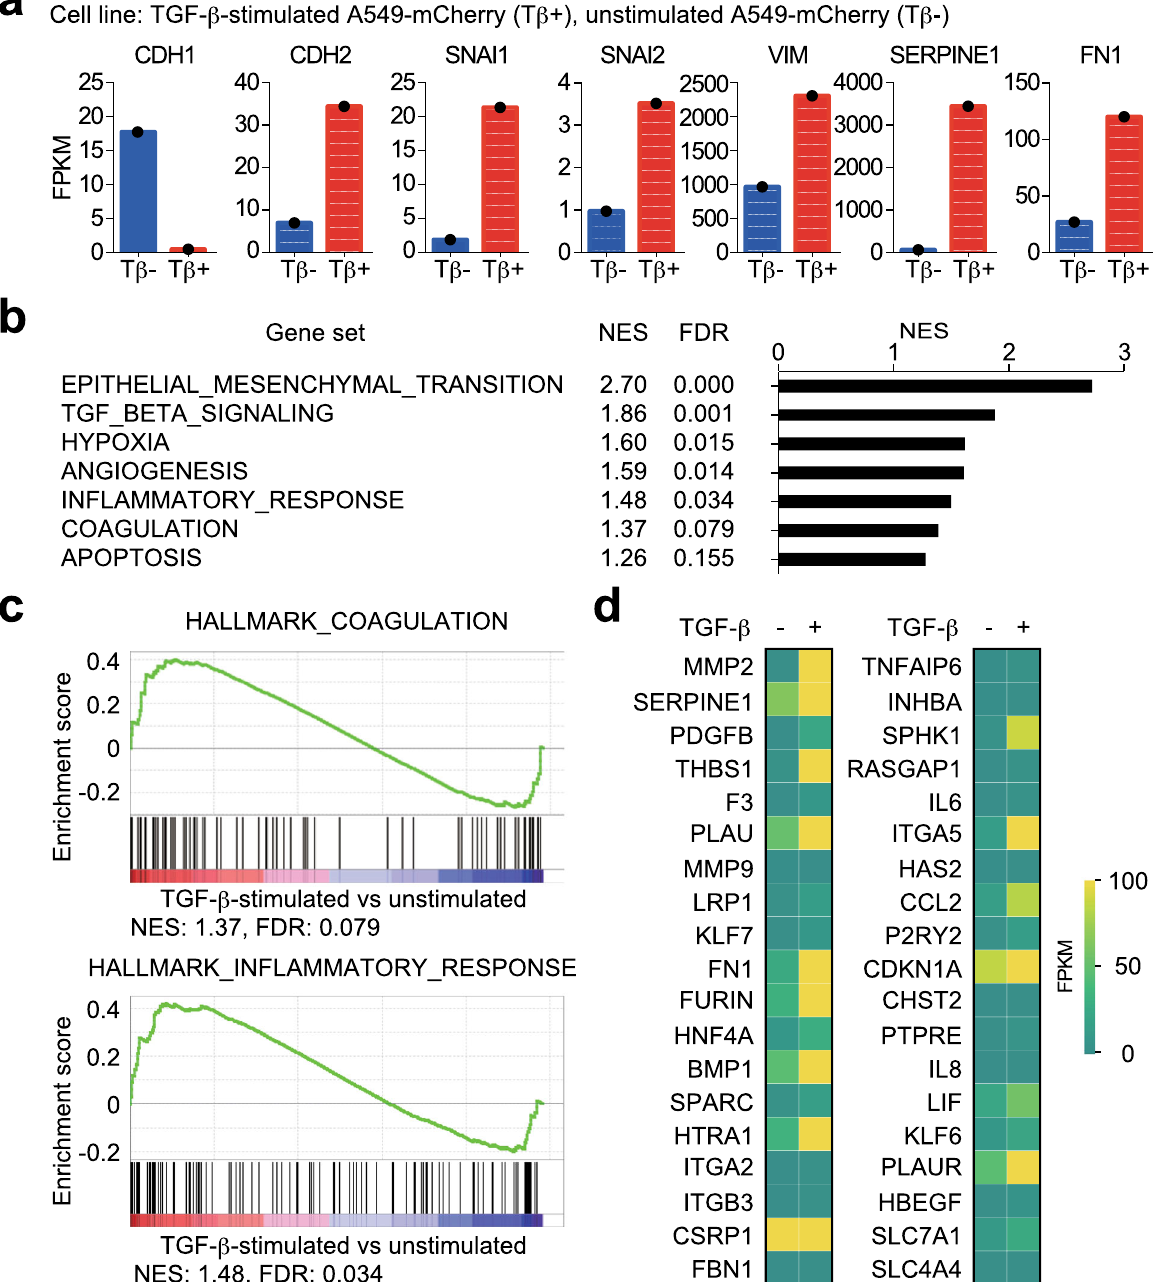
Fig. 5 Expression of the tumour microenvironment-related genes in TGF- β -stimulated cancer cells. Identi fi cation of targets of TGF- β in A549 cells using RNA-seq analysis. a Expression of epithelial-mesenchymal transition (EMT) markers in A549 cells. A549 cells were cultured in the absence ( “ T β − ” ) or presence of TGF- β 1 ( “ T β + ” ) for 3 days. Then, gene expression level was determined by RNA-seq analysis. Fragments per kilobase of exon per million reads mapped (FPKM) values of each gene are shown. b – d Gene expression data obtained in a were used for gene set enrichment analysis (GSEA). A list of the most enriched hallmark gene in “ T β + ” sets is presented in b . The normalized enrichment score (NES) and false discovery rate (FDR) are shown. Representative enrichment plots of the hallmarks are shown in c . Heat map showing the expression of genes listed in the hallmarks in d . Genes which were extracted in either or both hallmarks are